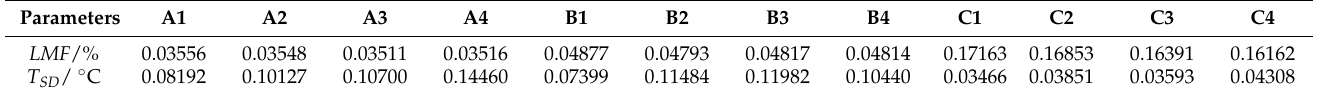
Table 12. Weight matrix analysis schemes and results at 75